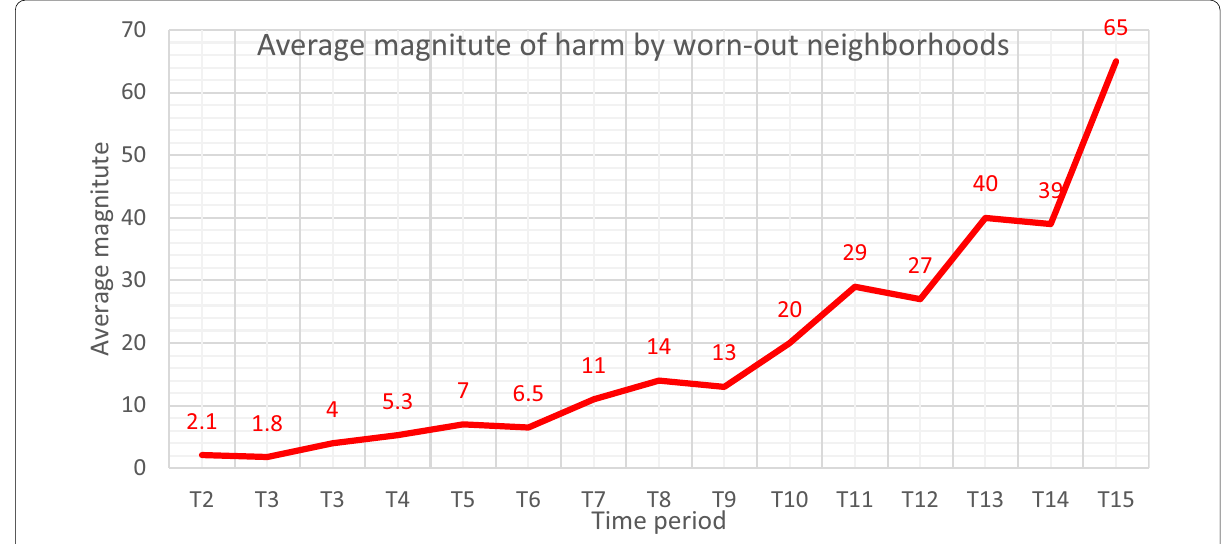
Fig. 2 Average magnitude of damage caused by worn-out neighborhoods in the